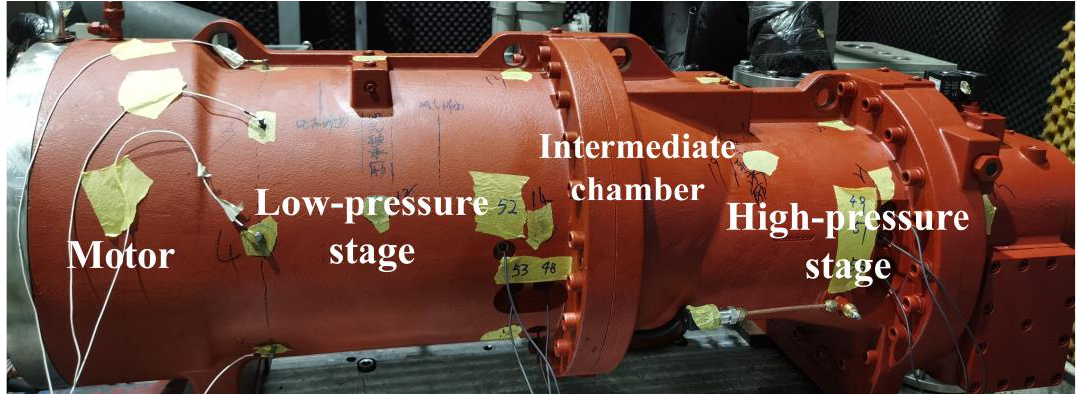
Figure 10. Photo of the newly designed two-stage refrigeration compressor.